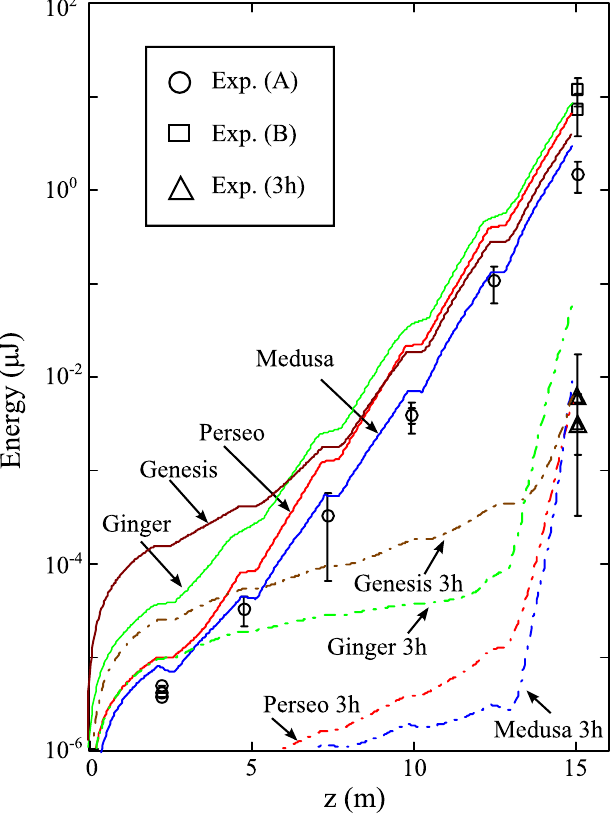
FIG. 11. Pulse energy vs longitudinal position in the undulator. Black symbols represent the measured data on the fundamental. Set (A) circles (average over 20 shots after the first undulator, z (cid:1) 5 m ), before optimization, set (B) squares (average over 50 shots), after optimizing laser to injector phase. Third harmonic (3h) triangles, were acquired with all the undulator gaps at resonance. Error bars represent (cid:2) 2 standard deviations of the shot to shot fluctuations (error bar is missing after the first section where the spectrum is the result of two integrations over 100 s). The lines represent simulations with PERSEO (red), GENESIS 1.3 (brown), MEDUSA (blue), and GINGER (green). The third harmonic simulation data are represented by dash-dotted